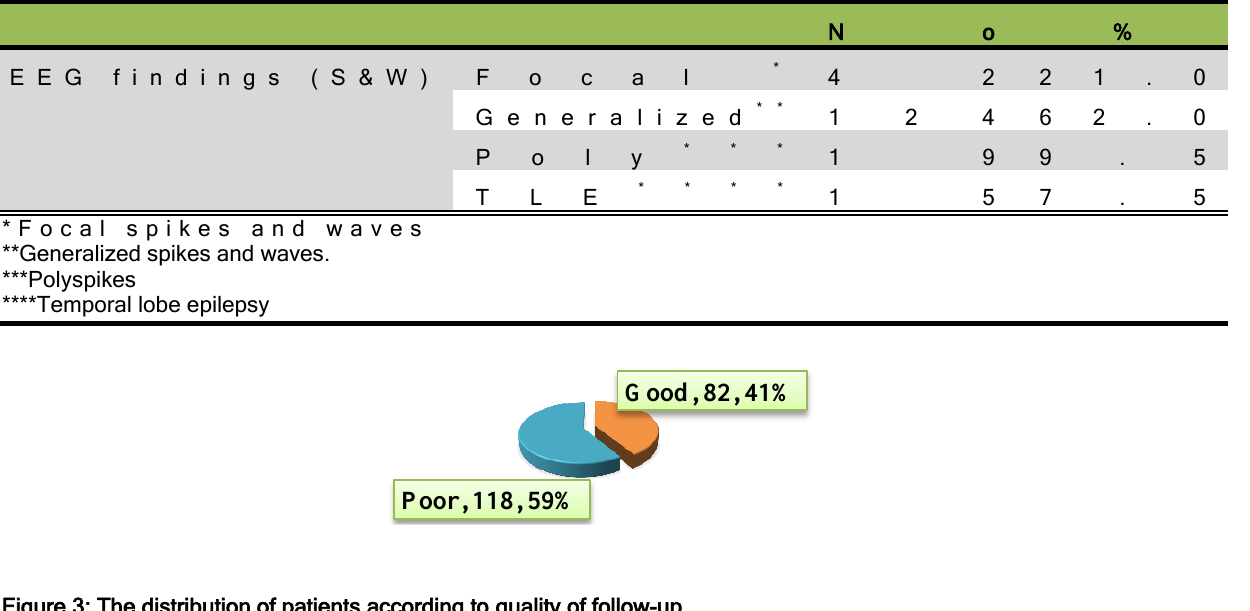
Figure 3: The distribution of patients according to quality of